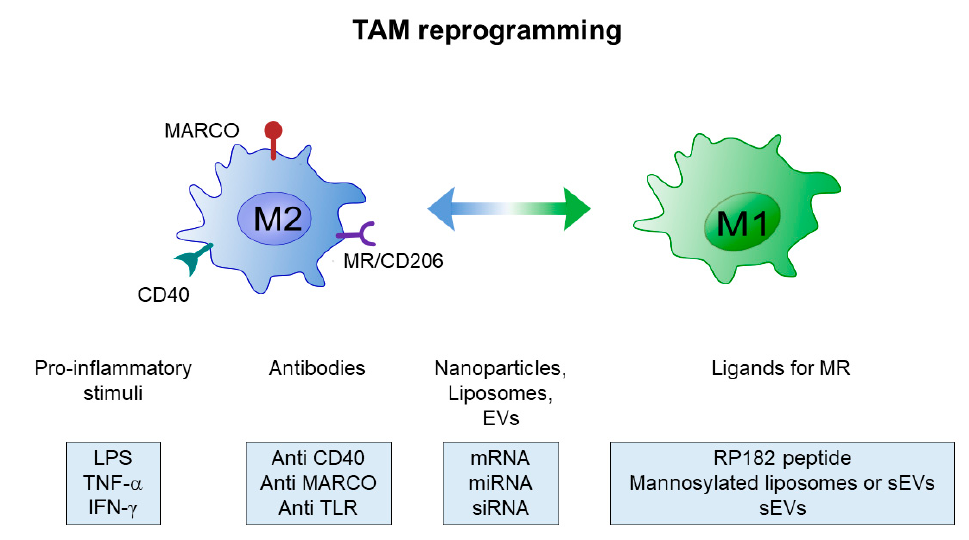
Figure 4. Scheme of current strategies for tumor-associated macrophage (TAM) reprogramming.